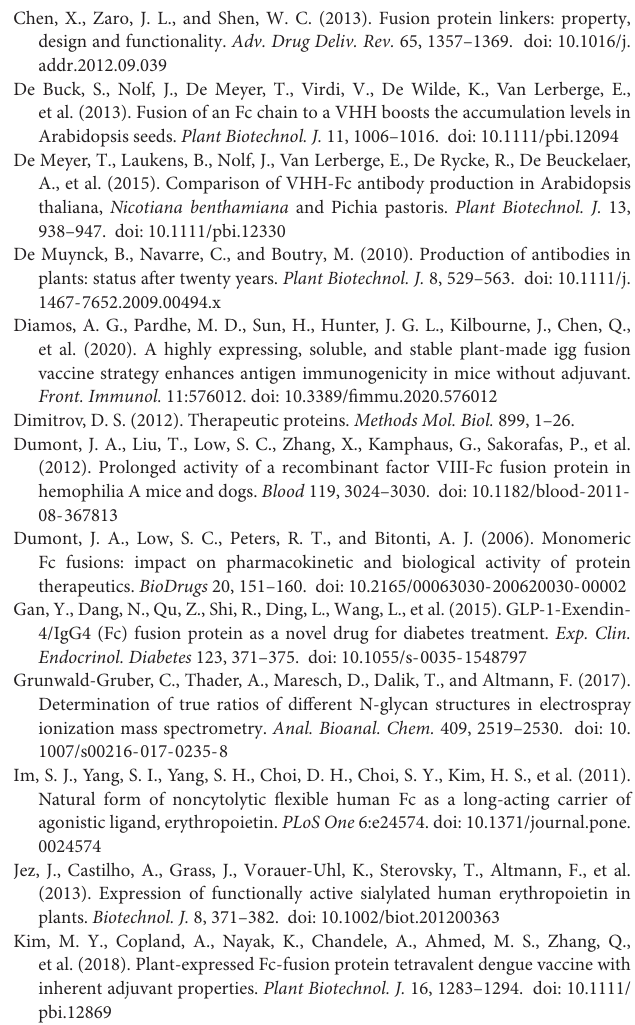
Supplementary Figure 1 | Peptide sequence of the proteins analyzed in this investigation. Supplementary Figure 2 | Analysis of the expression EPO-IgG1 variants in the apoplast. Supplementary Figure 3 | Analysis of the expression L Fc (non-fused). Supplementary Figure 4 | Site-specific N -glycosylation